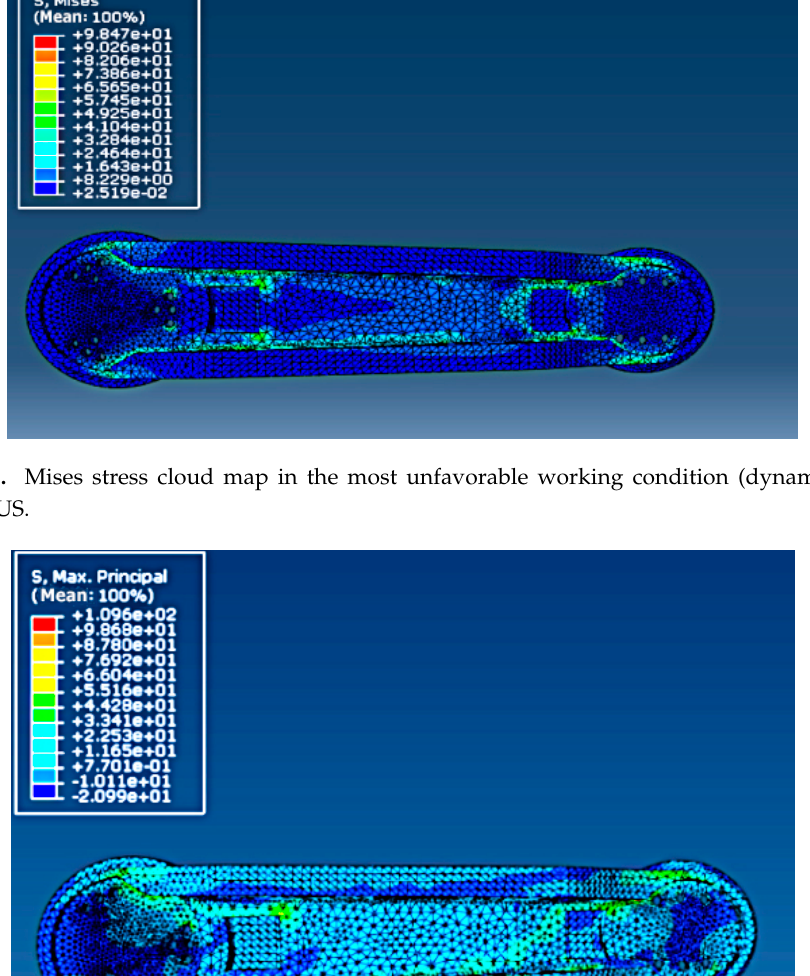
Figure 10. Mises stress cloud map in the most unfavorable working condition (dynamic loads) in ABAQUS.